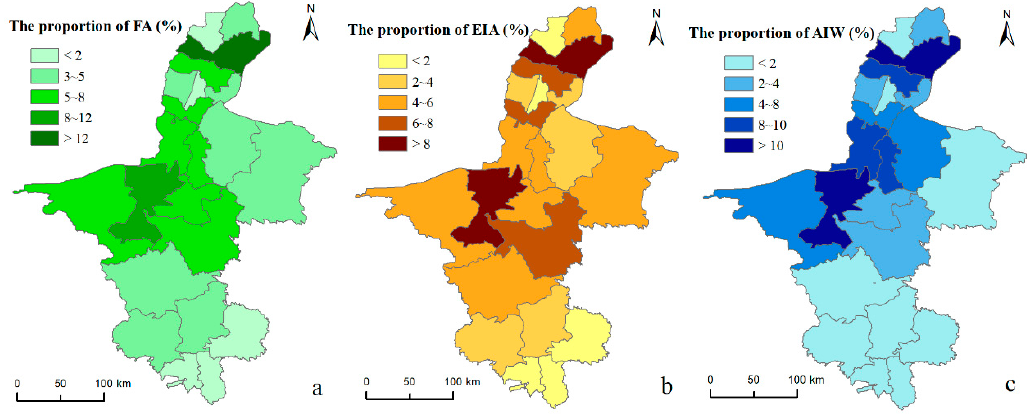
Figure 2. The distribution of annual mean agricultural water and land resources in Ningxia. ( a ) The proportion of farmland area (FA); ( b ) The proportion of effective irrigated area (EIA); ( c ) The proportion of agricultural irrigation water (AIW).